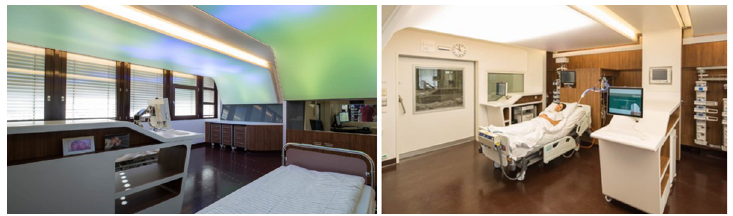
Fig 3. Circadian medicine in ICUs. Critically ill patients frequently exhibit disturbed or absent diurnal rhythms. This is likely to be a result of their illness and sedative measures but could also be related to the often-arrhythmic environment of an ICU (inadequate light exposure, parenteral nutrition, etc.). At the same time, they are arguably the best monitored patients, and vast amounts of routine clinical data are available with time courses for a variety of physiological parameters. We propose evaluating this treasure trove of information much more systematically with data science methods to detect the clock and improving light settings in the ICUs to target the clock. The analysis of clinical source data will help to characterize patients in the ICU in terms of their circadian rhythms, to identify predictors of circadian disruption as well as therapy-based improvements, and to associate circadian rhythms with clinical parameters (for example, delirium). In addition, since current ICUs do not provide adequate light settings, we have implemented a novel concept at Charite´ –Universita¨tsmedizin Berlin, consisting of a light ceiling for each experimental ICU bed that extends from the head above the patient to the patient’s feet [67]. Each light ceiling consists of multiple layers of light-emitting diodes designed to target the patient’s circadian clock. ICU, intensive care unit. Photos can be used with kind permission of GRAFT; photo credit is given to Tobias Hein